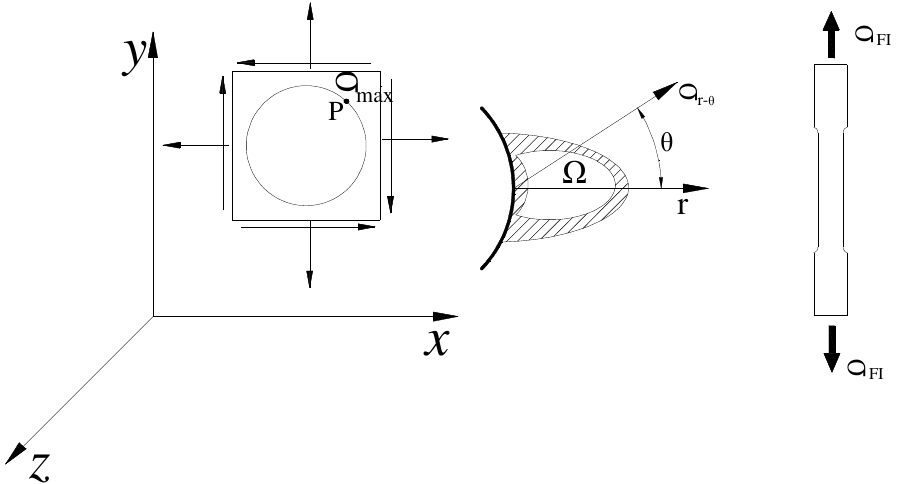
Figure 3. Basic model of the stress-field intensity approach.